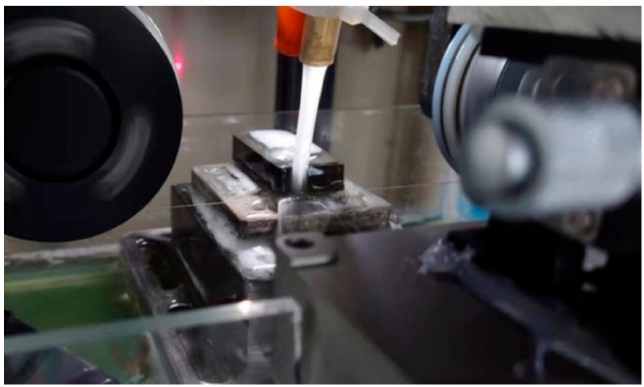
Figure 3. The flat wire bow during the 0.1 mm/min wire sawing